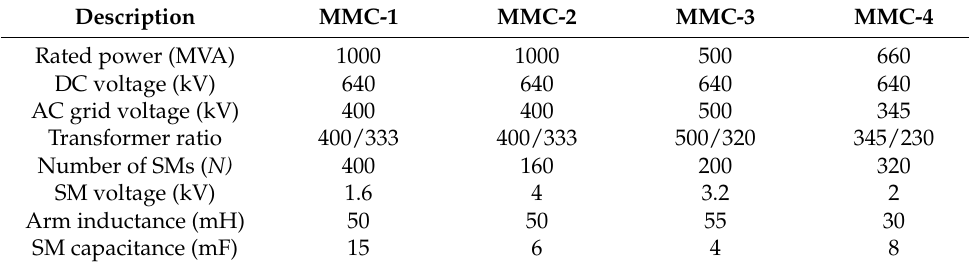
Figure 2. An FBSM structured three-phase MMC configuration (MMC-1). Table 1. MMC parameters of the MTDC